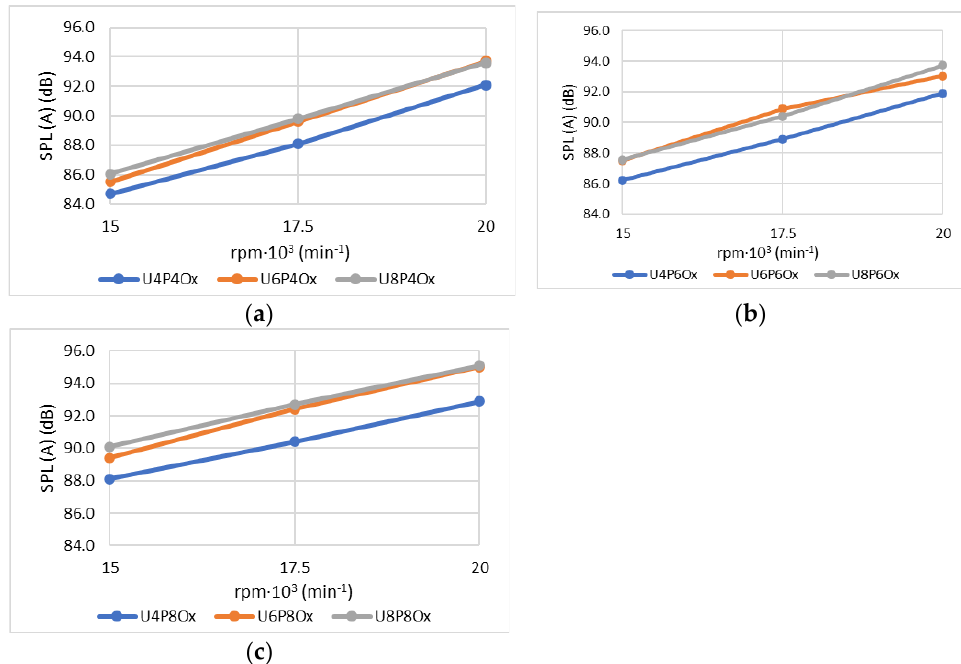
Figure 5. Dependence of sound pressure level (SPL) on revolutions at different radial depth of cuts and different feed speeds (( a ) — feed speed 4 m.min −1 , ( b ) — feed speed 6 m.min −1 , ( c ) — feed speed 8 m.min −1 ).